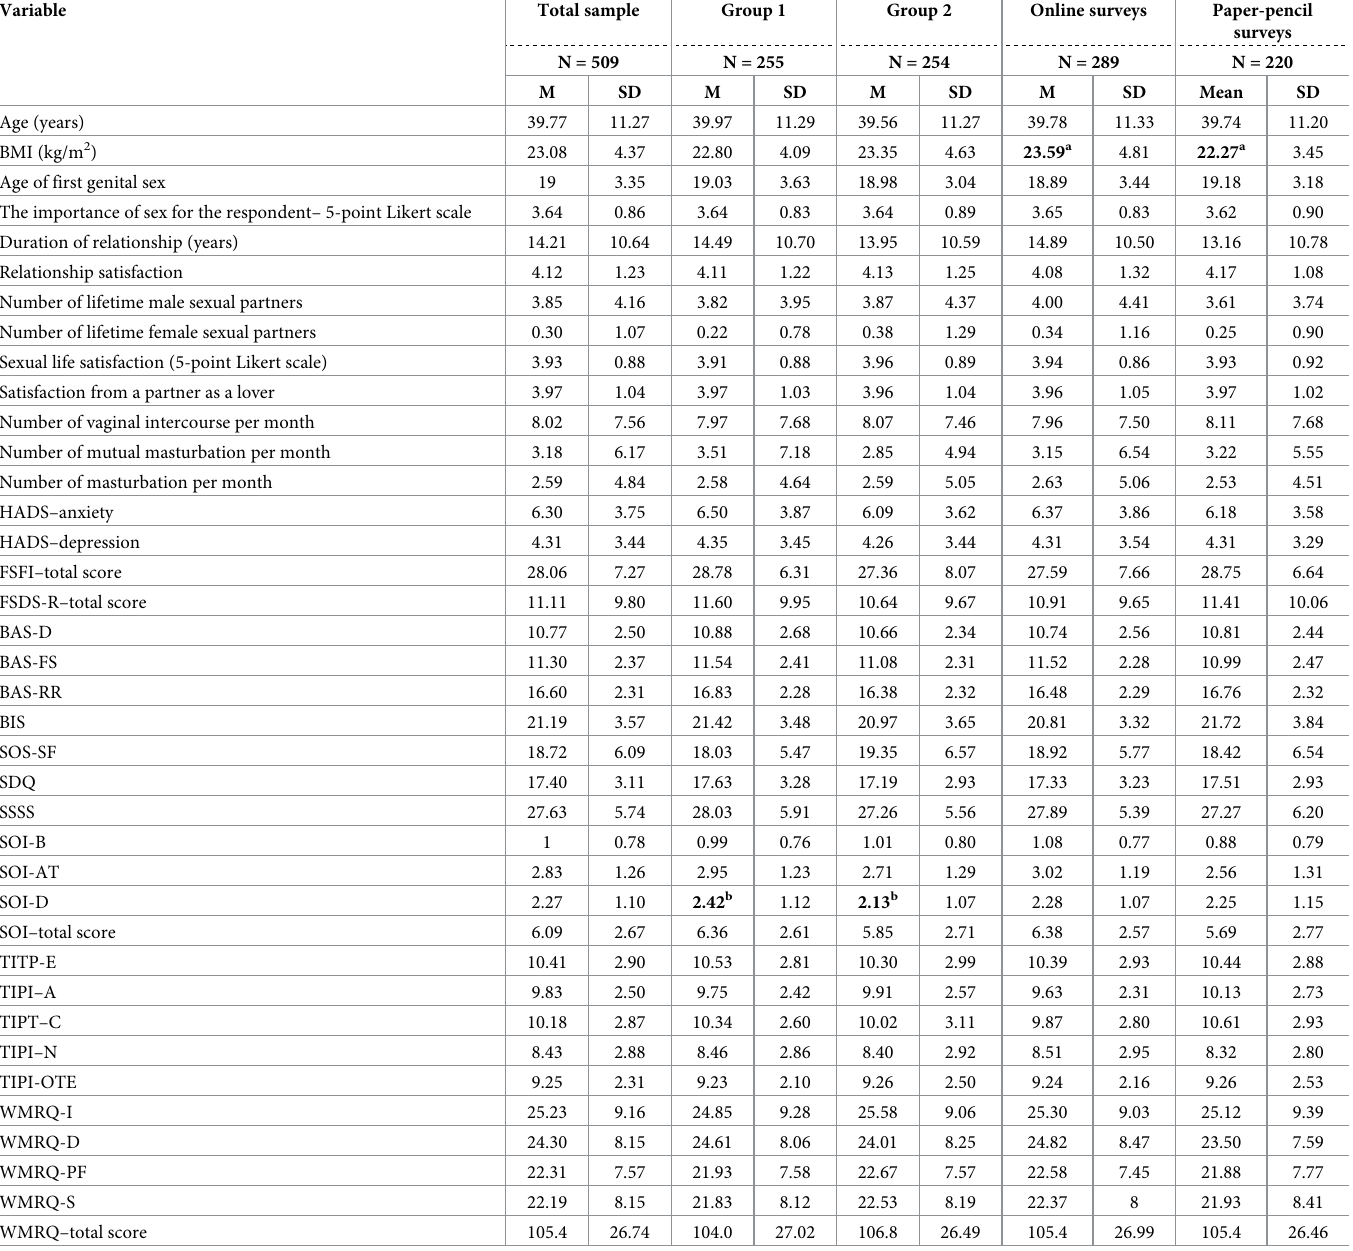
Table 1. Characteristics of the study sample. Variable Total sample Group 1 Group 2 Online